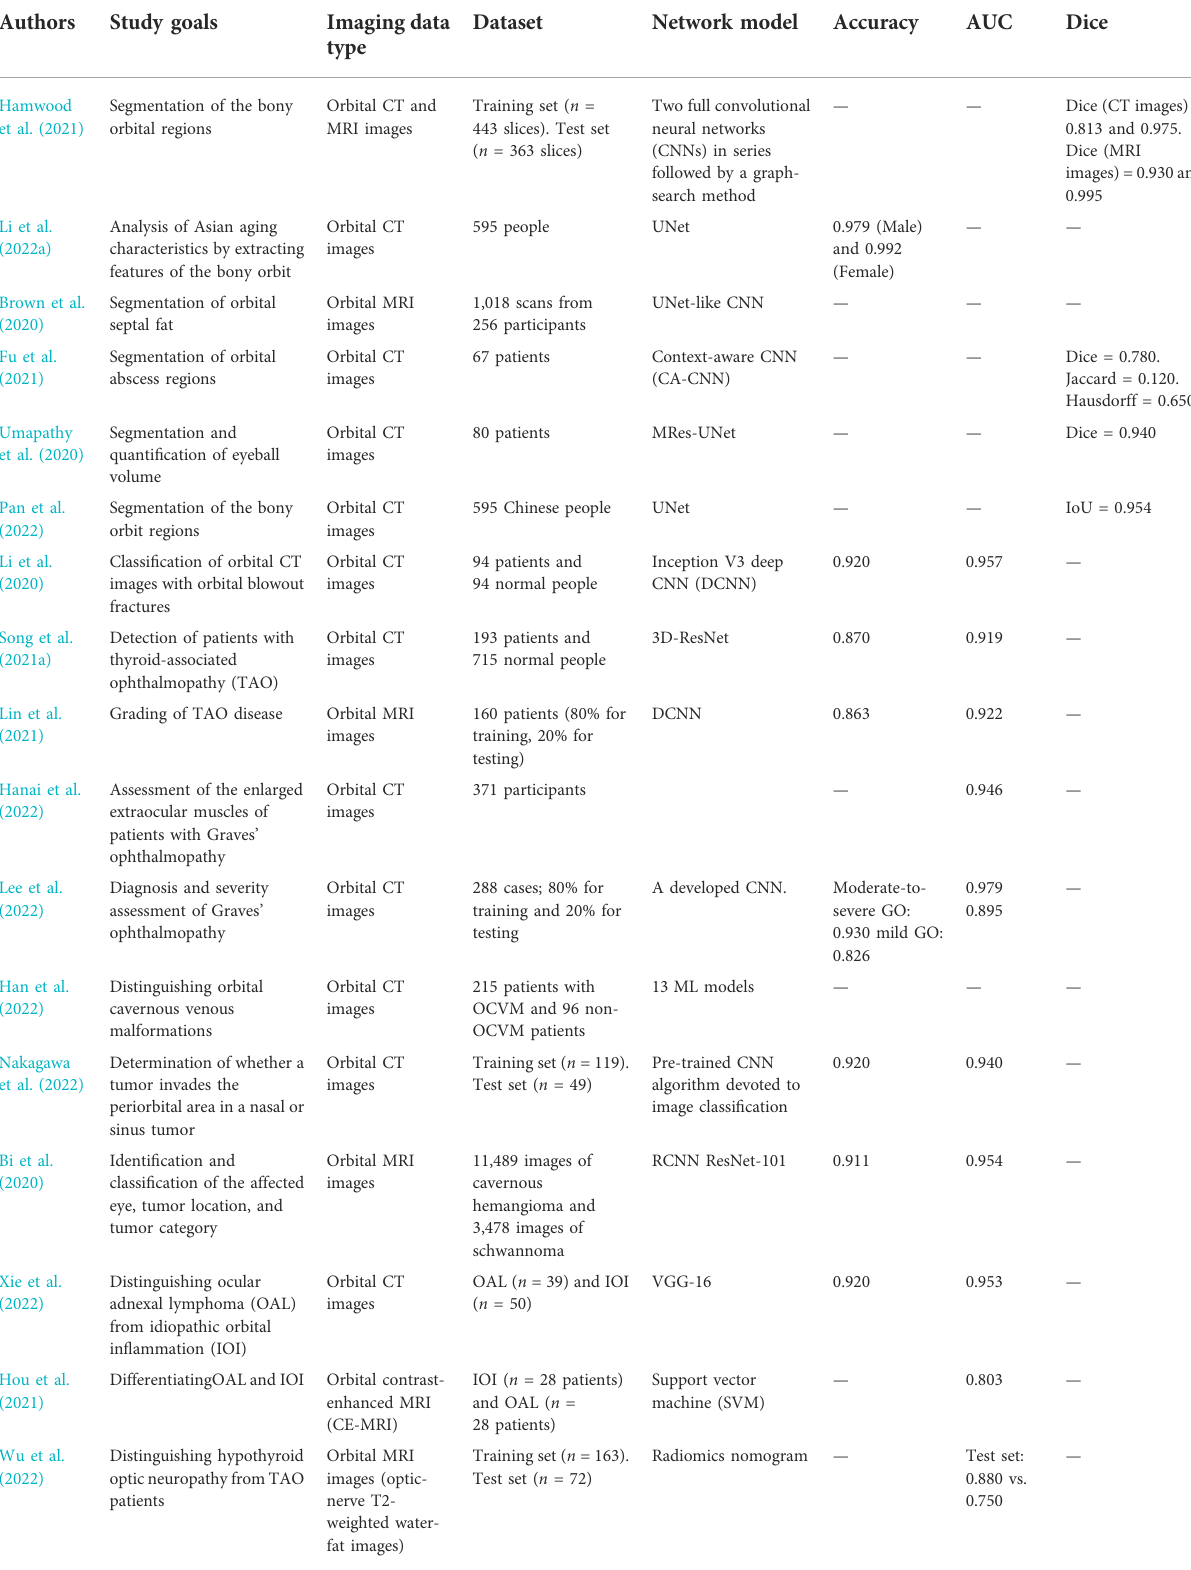
TABLE 1 AI-related studies utilizing orbital CT/MRI